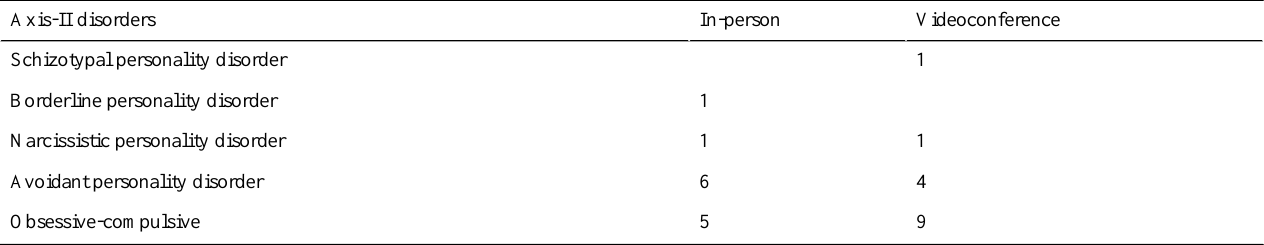
Table 2. The number of clients that met the criteria for Axis-II disorders at